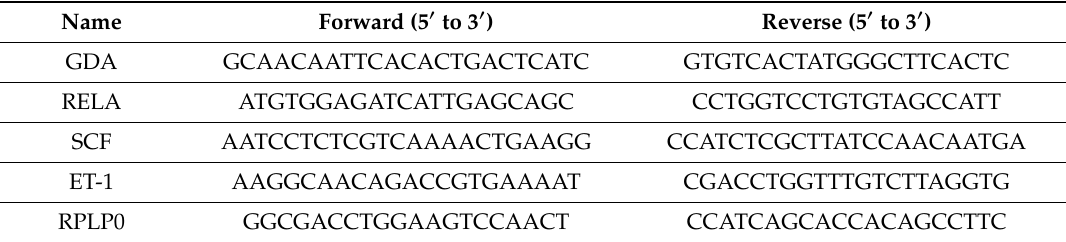
Table 2. Specific primer sets for each